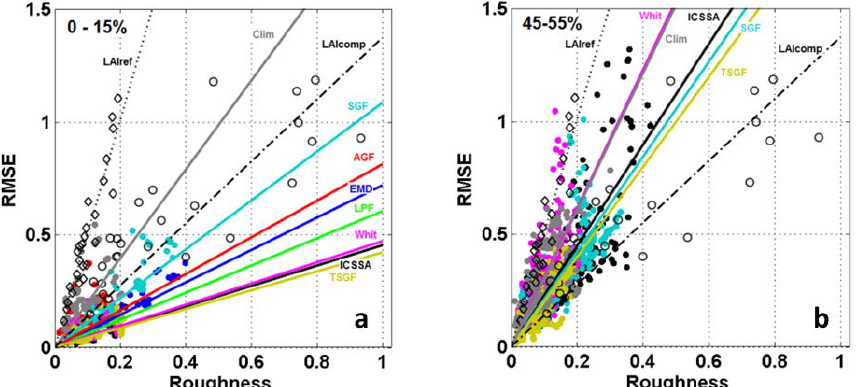
Fig. 11. RMSE as a function of Roughness observed over the reconstructed times series using the several methods. Color dots correspond to the values for the different methods over the 25 sites for cases with %gap in the selected classes of occurrence of missing data: 0–15% (a) and 45–55% (b) . Note that EMD, LPF and AGF are only displayed for the lowest occurrence of missing data (0% < %gap < 15%). Black circles correspond to LAI comp and black diamonds to LAI ref . Lines correspond to the zero-offset linear